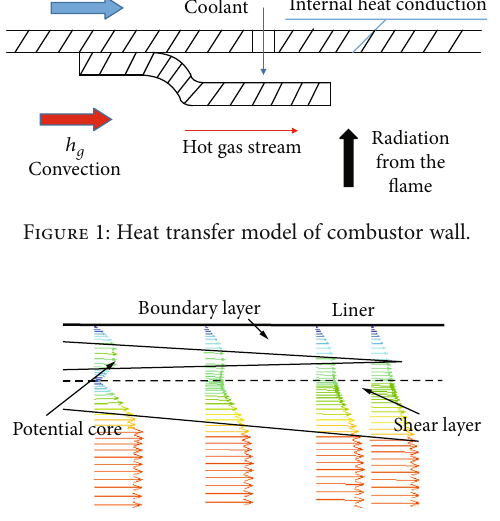
Figure 2: Velocity distribution of simple ideal slot- fi lm